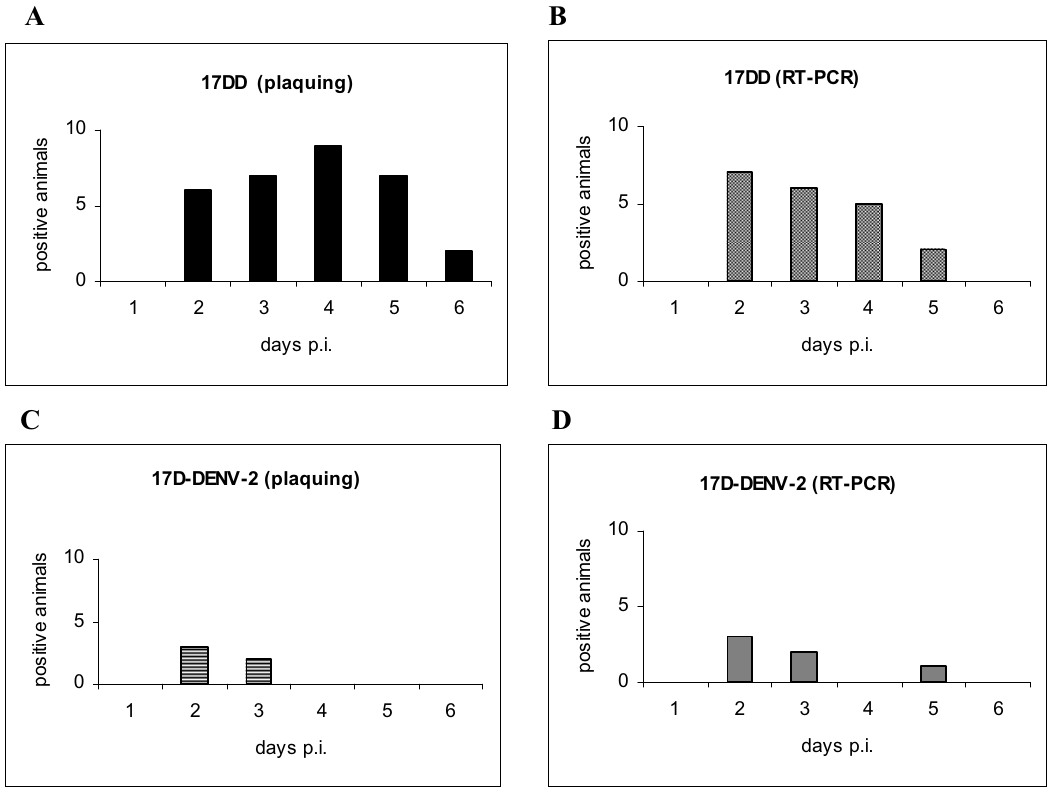
Fig. 3 – Detection of YFV 17DD and 17D-DENV-2. Parental YFV 17DD (Panels A and B) and 17D-DENV-2 (Panels C and D) were inoculated intracerebrally. Positive animals / days p.i. detected by plaque assay (Panels A and C) and real-time RT-PCR (Panels B and D).